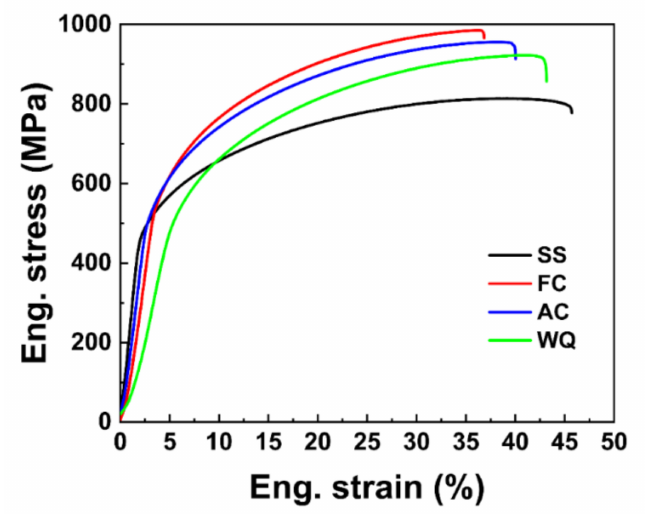
Figure 5. Room-temperature engineering stress–strain curves of Al 0.5 CoCrFeNi HEA as sintered and treated with different cooling rates. Table 2. Mechanical properties of Al 0.5 CoCrFeNi HEA as sintered and treated with different cool- ing